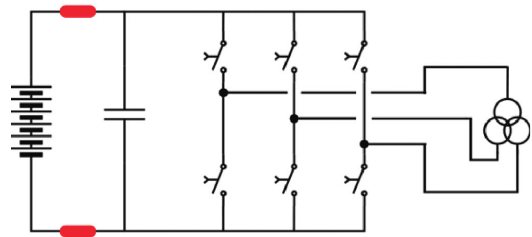
Figure 3: Traction inverter’s DC link short-circuit detecting location.